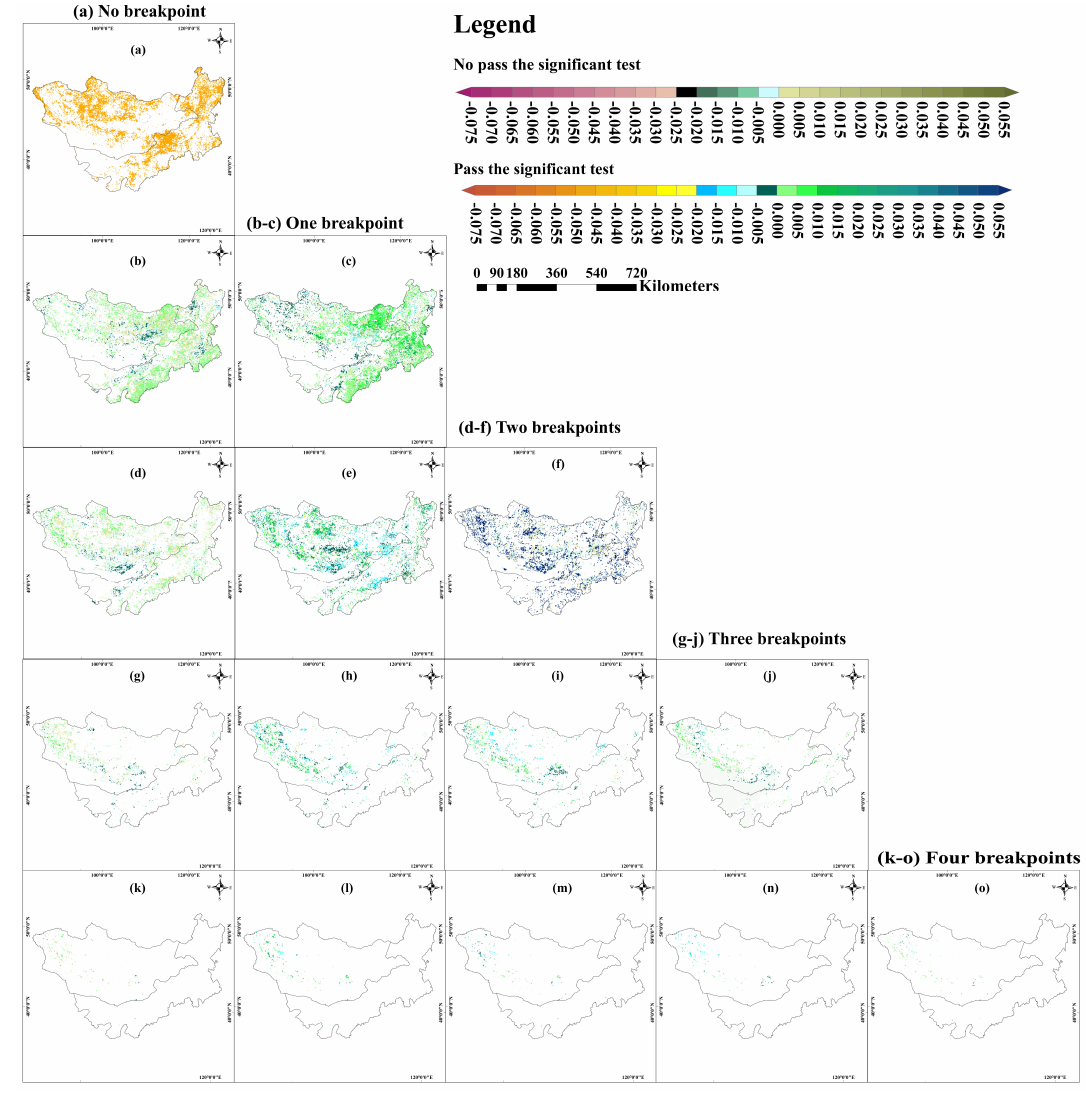
Figure 5. BFAST detected shifts in the NDVI trend before and after the breakpoints for 1982–2015 in the Mongolian Plateau. ( a ) no breakpoint, ( b – c ) one breakpoint, ( d – f ) two breakpoints, ( g – j ) three breakpoints, ( k – o ) four